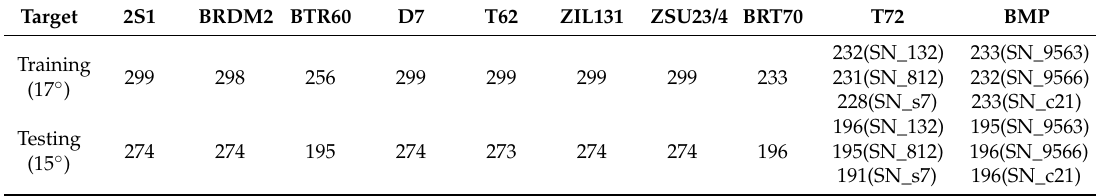
Table 4. The number of images for training and testing about the ten targets under SOC.